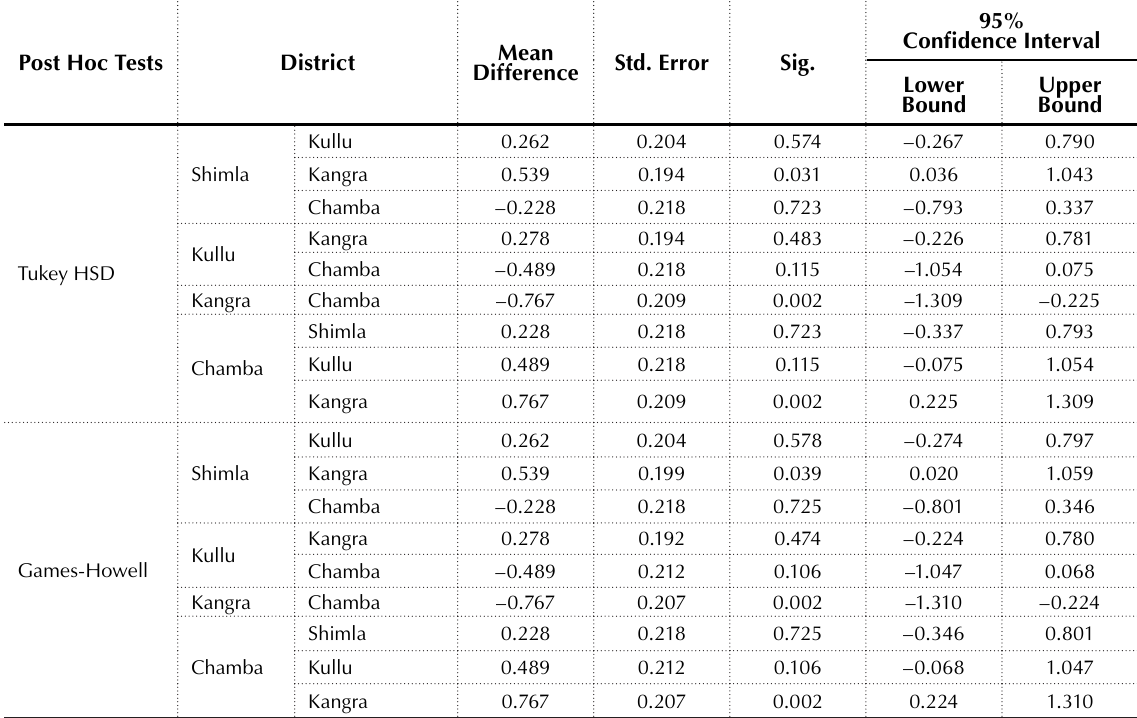
Table 5. Post-Hoc contrasts for district wise opinions of stakeholders on economic effects of tourism on tourism destination